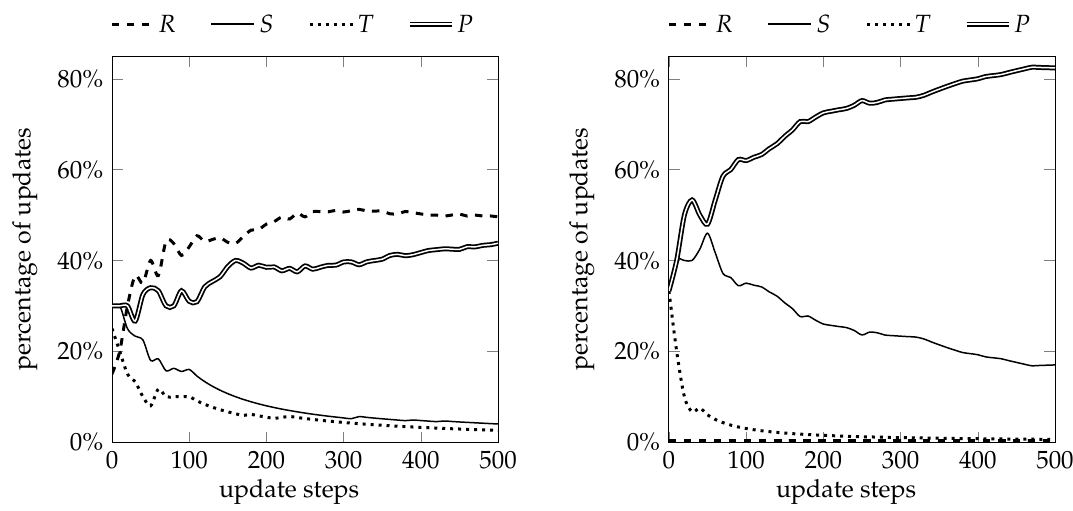
Figure 5. Percentages of the cumulated number of updates steps from R -, S -, T -, and P -agents for “ALL imitate” (left) and “AVG imitate” (right).